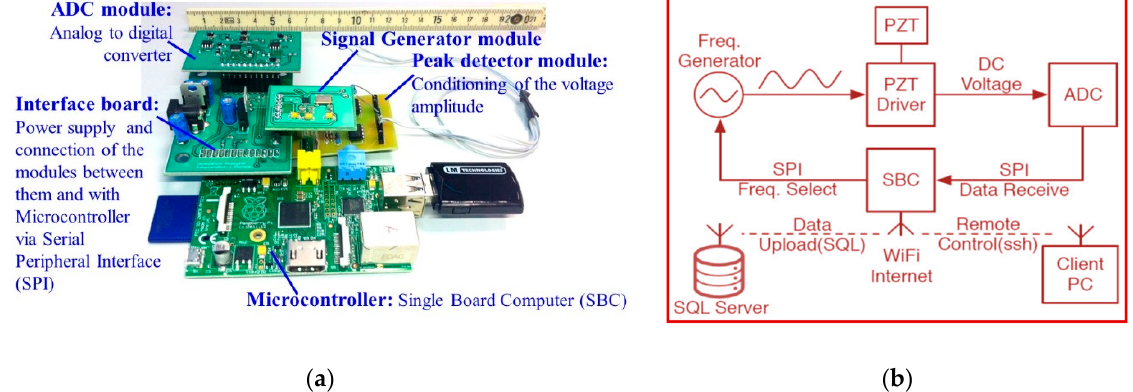
Figure 1. Instrumentation of the developed PZT-based SHM system ( a ) device; ( b ) block diagram of the interface board.